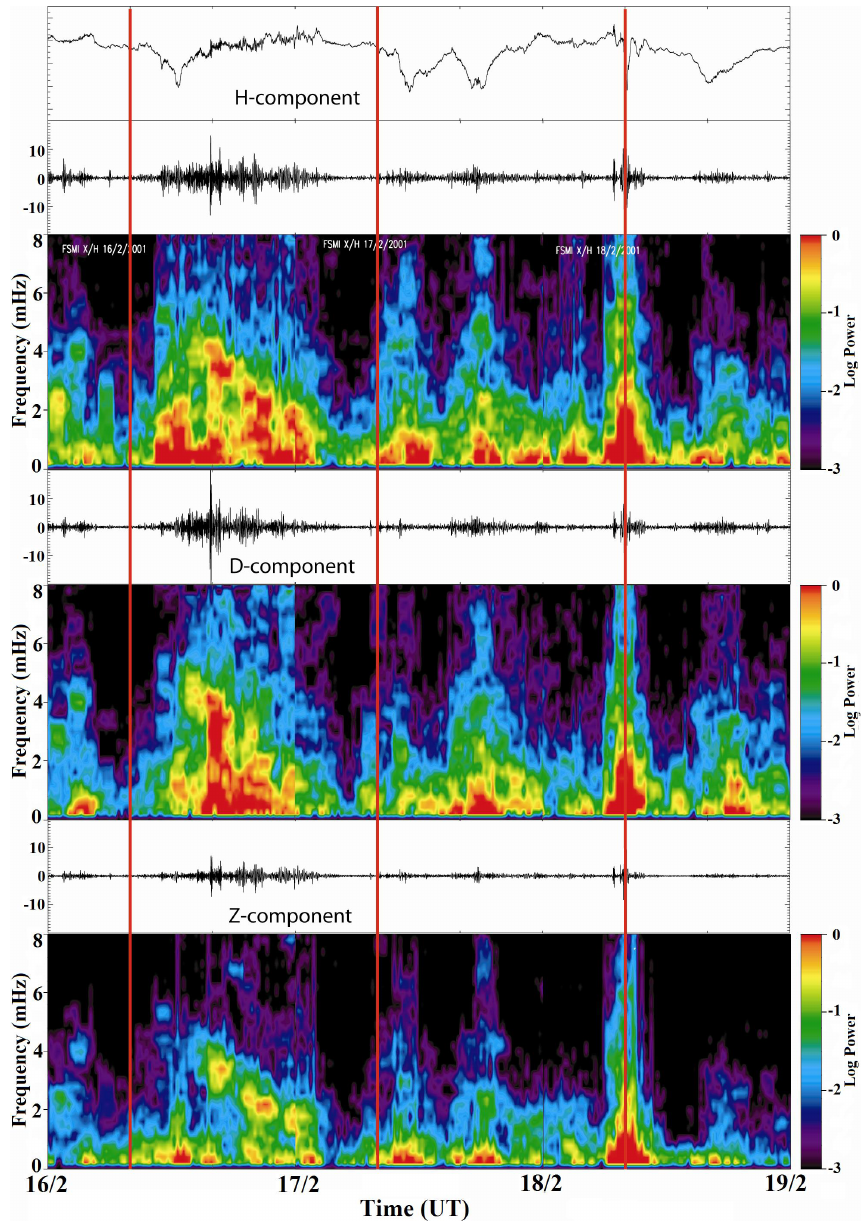
Fig. 3. Ground magnetometer measurements from station Fort Smith (67.45 ◦ geomagnetic latitude, 306.15 ◦ longitude and L=6.84), close to the footprint of GOES-10 (66 ◦ latitude, 296 ◦ longitude). Local midnight on each day is shown with the red